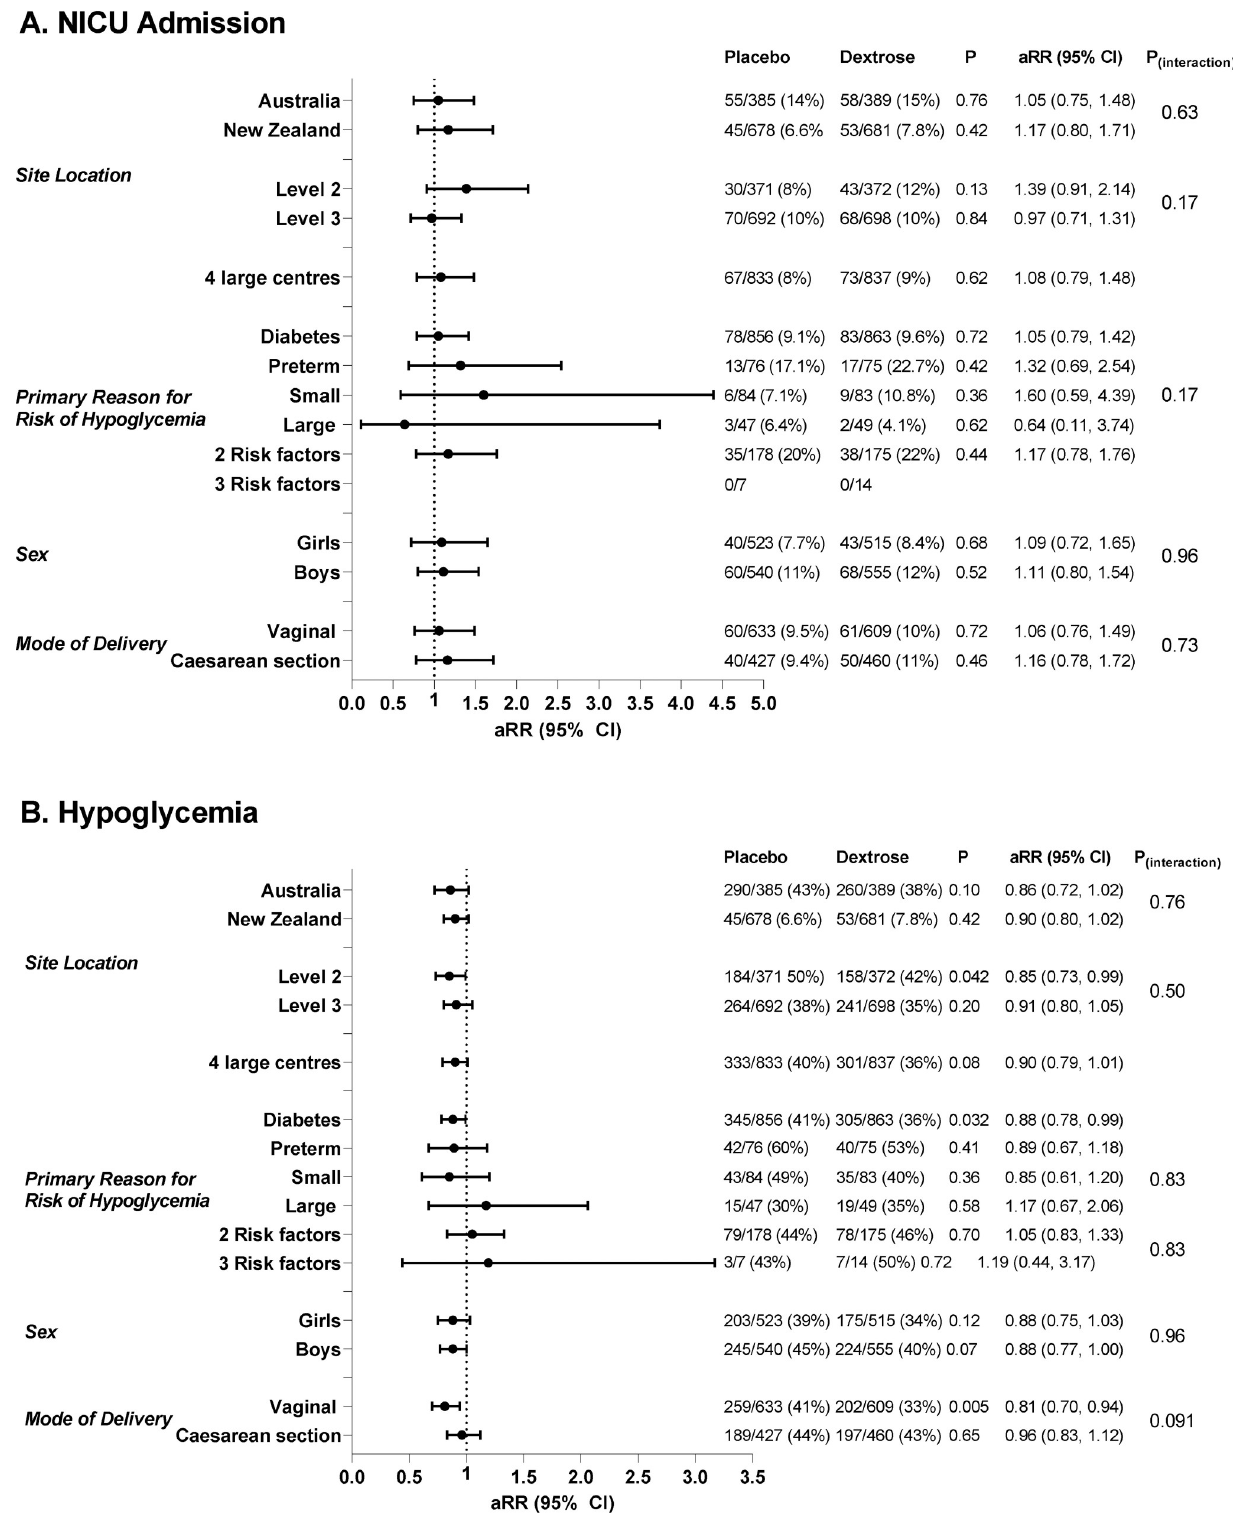
Fig 2. Subgroup analyses for the effects of dextrose gel versus placebo on risk of neonatal intensive care unit (NICU) admission and hypoglycemia. (A) NICU admission; (B) hypoglycemia. Horizontal lines indicate adjusted relative risks (aRRs) and 95% confidence intervals.